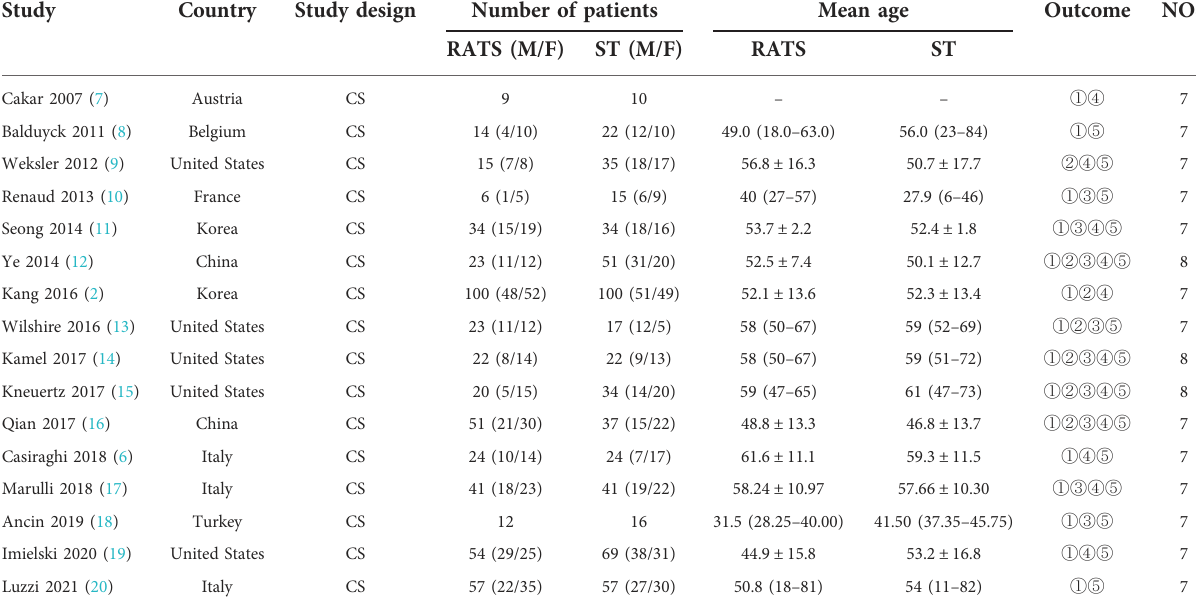
TABLE 1 Included studies